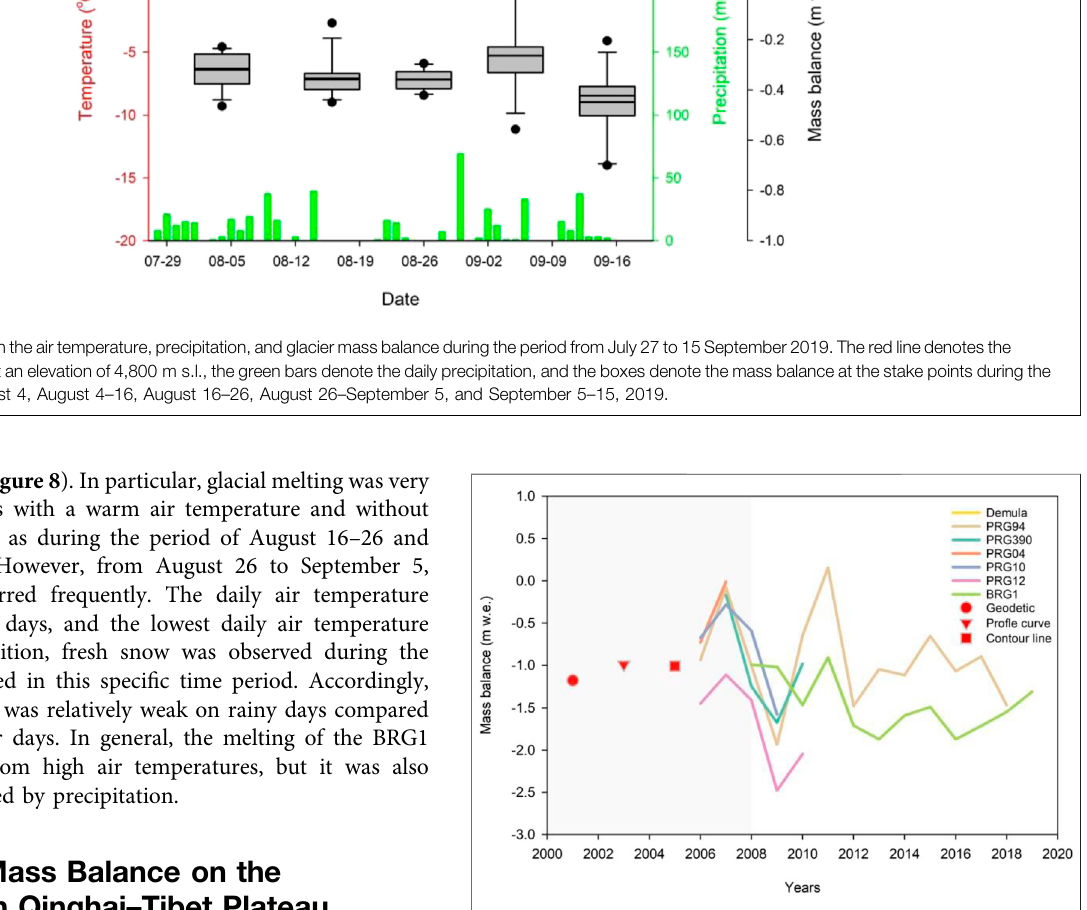
FIGURE 9 | Mass balances of glaciers with in situ records on the southeastern Qinghai – Tibet Plateau from 2000 to 2019. In plots, PRG04, 10, 12, 94, and 390 denote Parlung River Glaciers Nos. 04, 10, 12, 94, and 390, respectively. The BRG1 denotes the Baishui River Glacier No.